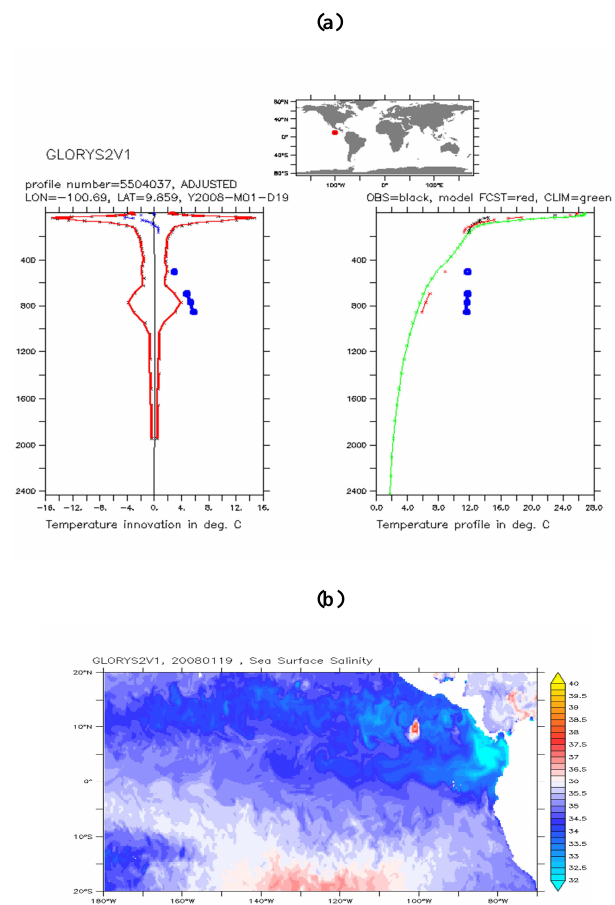
Fig. 5. Example of a suspicious temperature vertical profile at 100.69 ◦ W, 9.86 ◦ N, highlighted by the QC on the CORA3.1 dataset. (a) Left panel shows temperature innovation profile in blue and temperature innovation threshold in red. Right panel shows the absolute vertical temperature profile (observation in black, clima- tology in green and model in red). Large blue dots correspond to “bad” innovations or “bad” observations. (b) When this profile is assimilated, an abnormal value of salinity appears at the position of this profile.